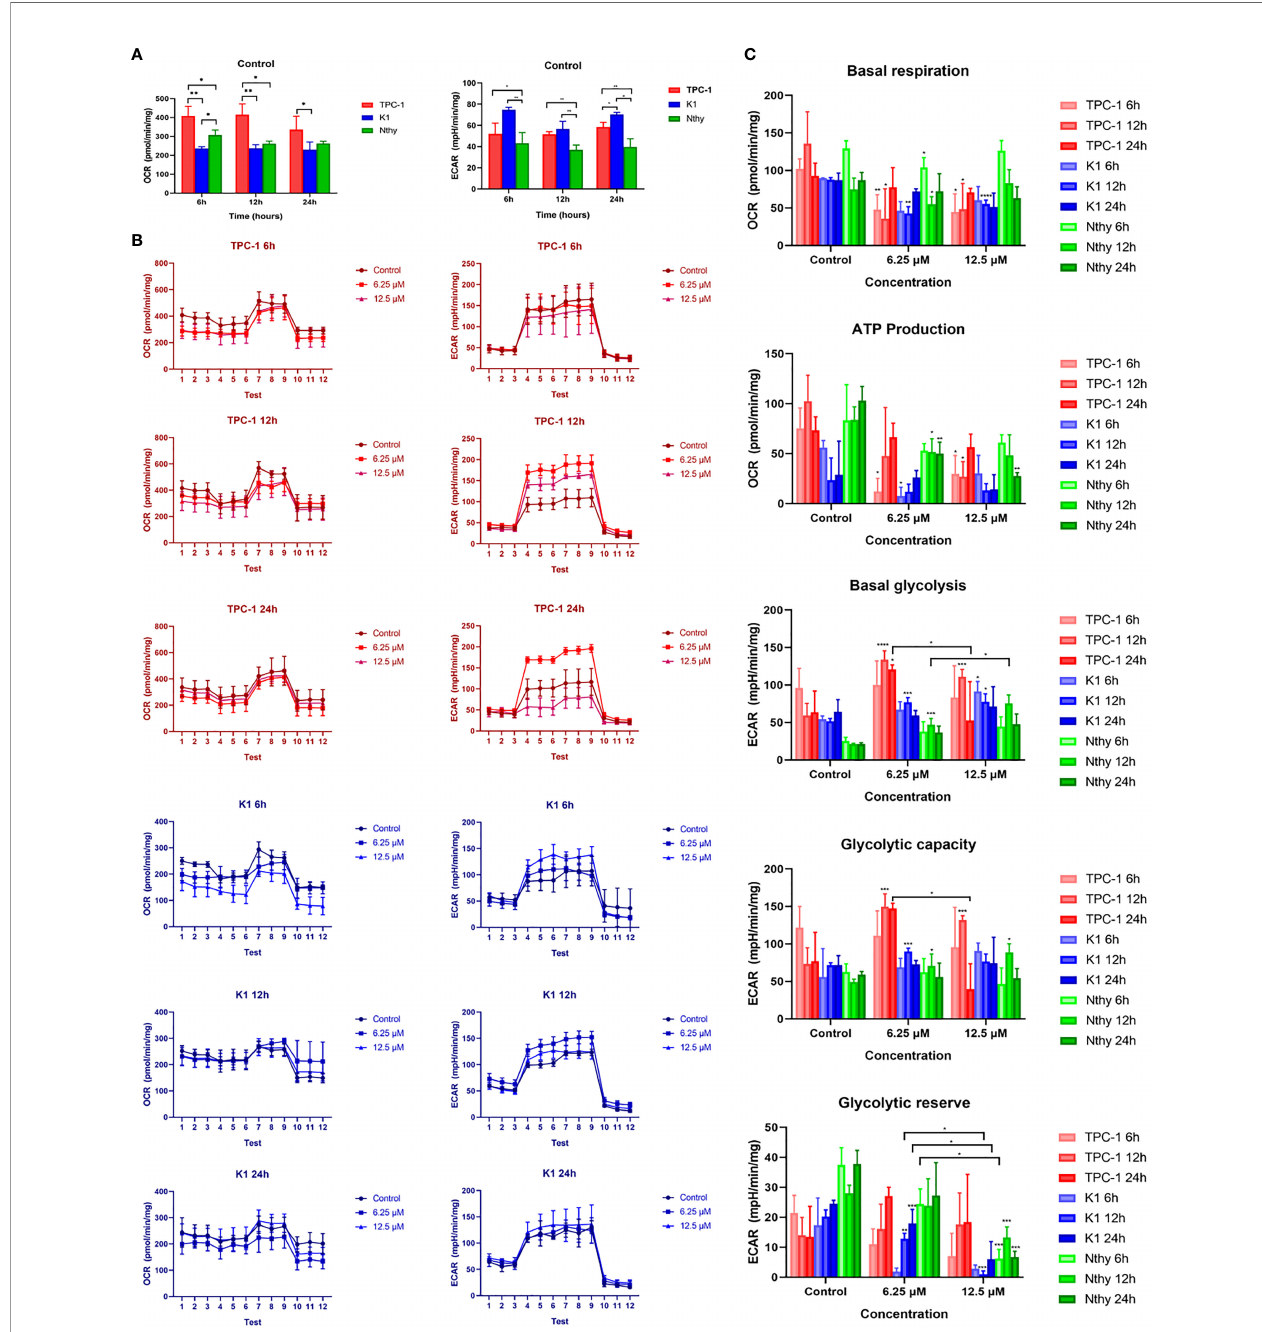
FIGURE 2 | Metabolism phenotypes of normal thyroid follicles and papillary thyroid carcinoma cells with and without mitochondrial inhibition. The metabolic phenotypes of the PTC cell lines (K1 and TPC-1) differed in terms of baseline OCR (pmol/min/mg) and ECAR (mpH/min/mg) (A) . TPC-1 cells had a signi fi cantly higher OCR and signi fi cantly lower ECAR, compared with K1 and Nthy cells. Three sequential tests were performed after three injections of the corresponding drugs: oligomycin, FCCP, and Rot/AA for OCR determination; glucose, oligomycin, and 2-DG for ECAR determination. The dynamics of the metabolic phenotype are